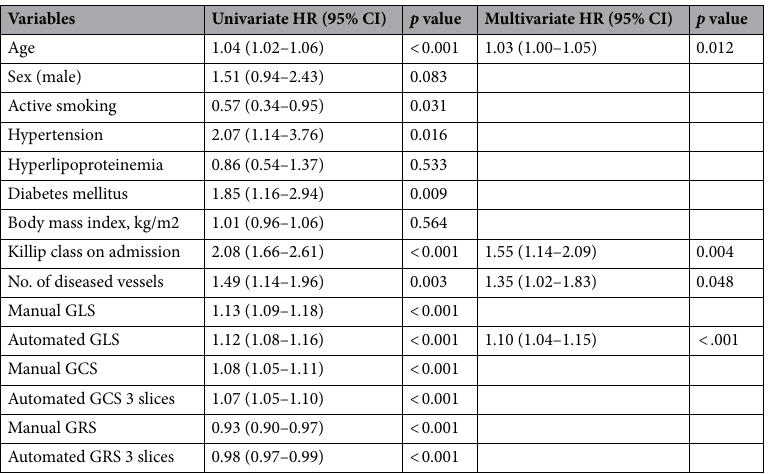
Figure 4. Bland-Altmann plots for agreement of manual and automated strain; GLS, GCS 3 slices and GCS all slices. Agreement between manual and automated strain values represented by Bland-Altmann plot, y axis represents the difference (manual-automated) and x axis is the mean of manual and automated values. GCS, global circumferential strain; GLS, global longitudinal strain.